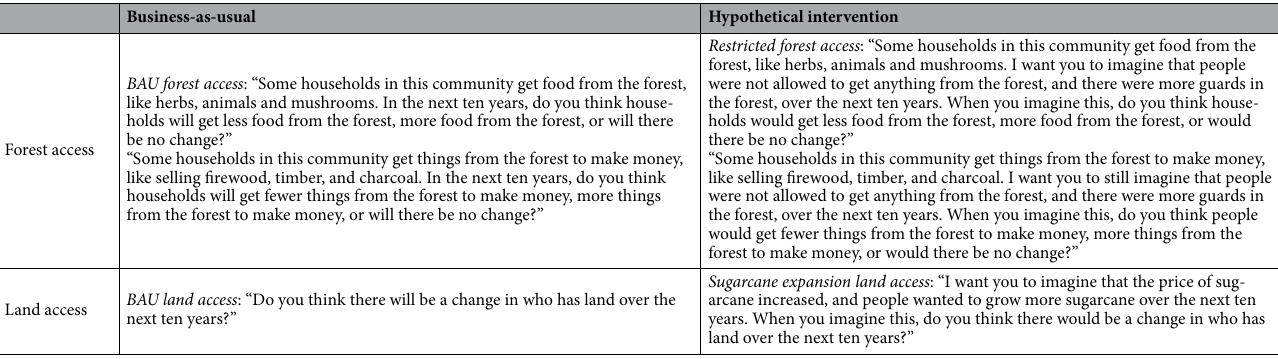
Table 1. Four scenarios were presented to respondents, contrasting business-as-usual (BAU) scenarios against hypothetical changes in land